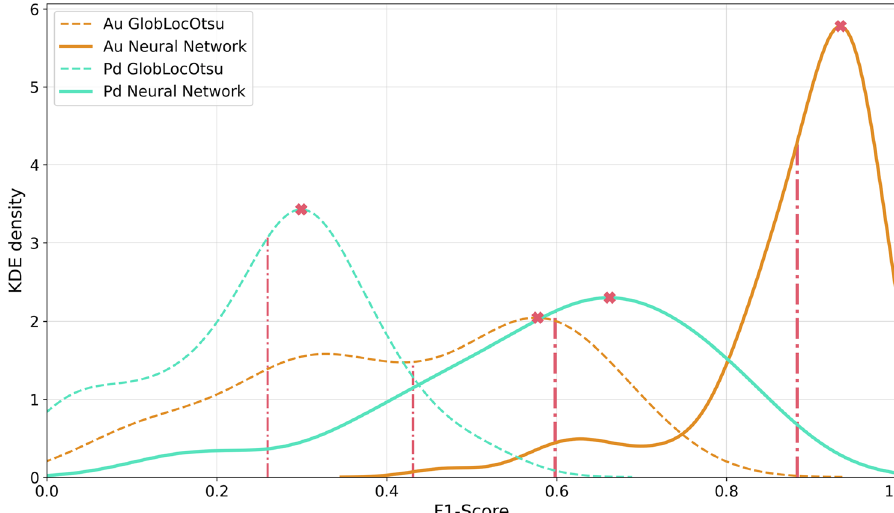
Fig. 4 KDE-plots for achieved F1-Scores. Graphs were generated using a Gaussian kernel and Scott ’ s rule 53 . Calculated F1-score means are illustrated by red dash-dotted lines, while maximum values of the KDE-plots are denoted with red crosses. F1-score values: Au GlobLocOtsu = 0.431, Au neural network = 0.883, Pd GlobLocOtsu = 0.260, Pd neural network = 0.598. KDE maxima at Au GlobLocOtsu = 0.578, Au neural network = 0.934, Pd GlobLocOtsu = 0.300, Pd neural network =